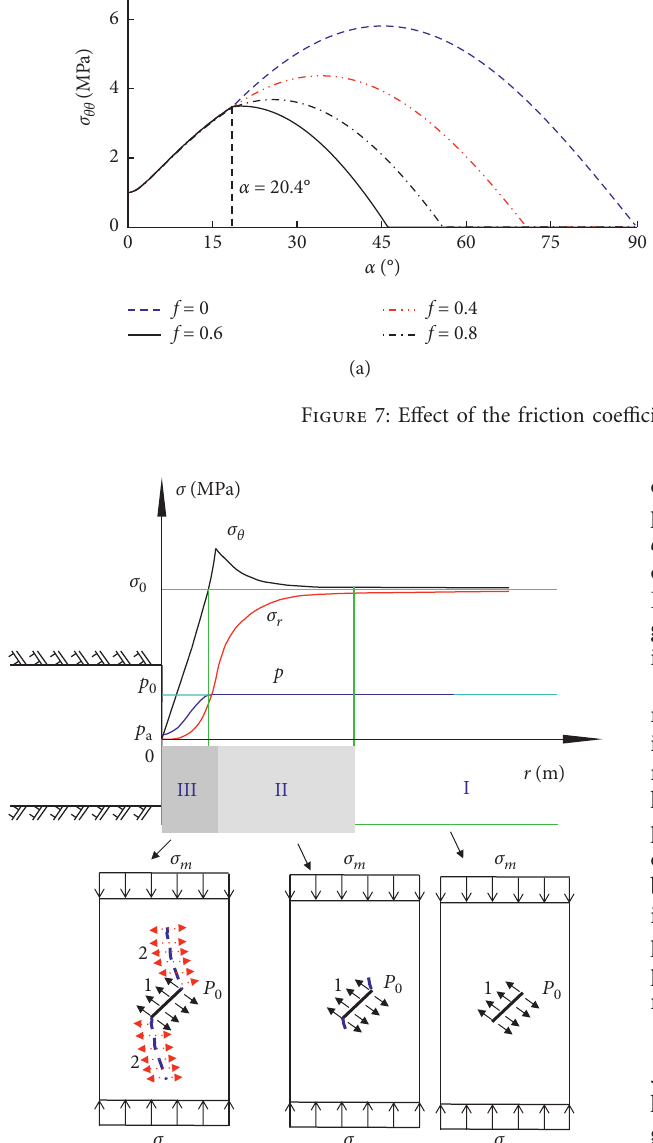
Figure 8: The stress state of coal in front of the working